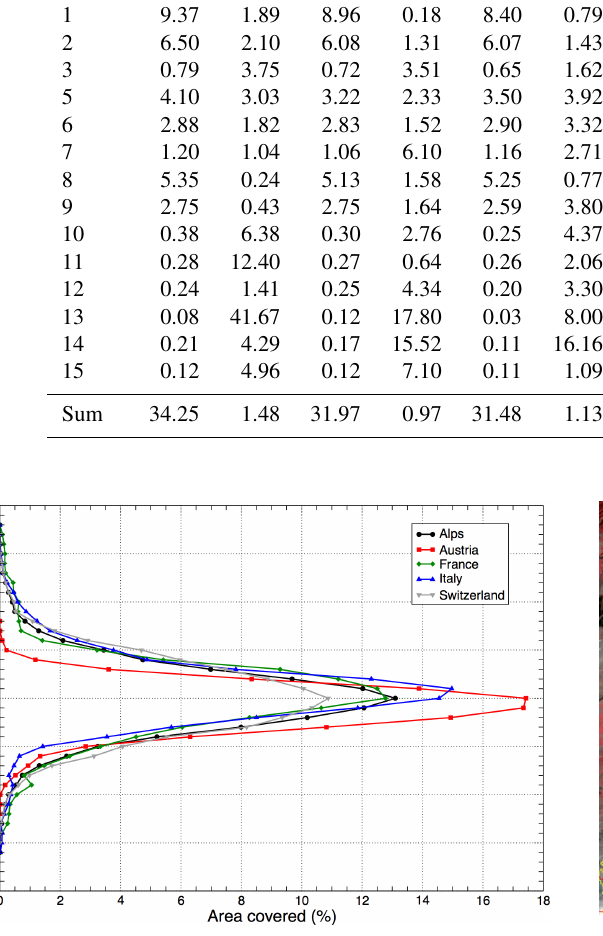
Figure 9. Visualization of the strong glacier area shrinkage between 2003 (yellow) and 2015 (red) for a subregion of the Zillertal Alps (Austria and Italy). The yellow cross on the right marks the coor- dinates 47.0 ◦ N, and 11.88 ◦ E (image source: Copernicus Sentinel data